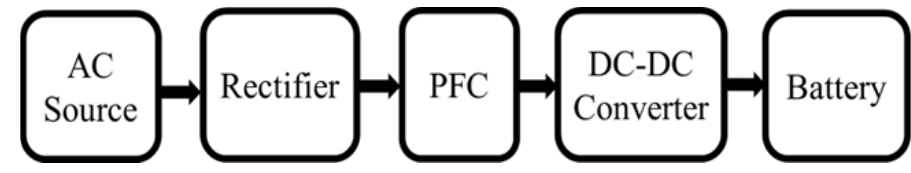
Figure 8. General EV’s Charger Circuit.